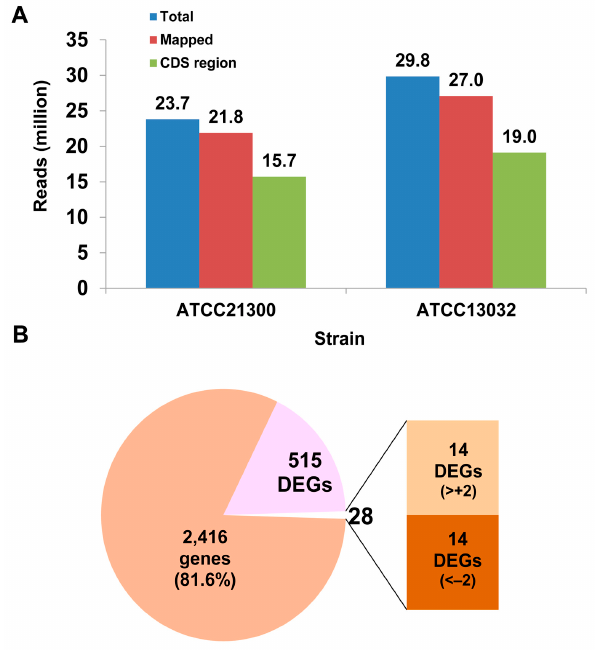
Figure 1. Characterization of global transcriptome in Corynebacterium glutamicum ATCC21300 and ATCC13032. ( A ) The total number of mRNA-Seq (sequencing) reads mapped in each C. glutamicum strain library; and ( B ) differentially expressed genes (DEGs) in C. glutamicum ATCC21300. Detailed information is shown in Table S2. CDS: coding sequencing.